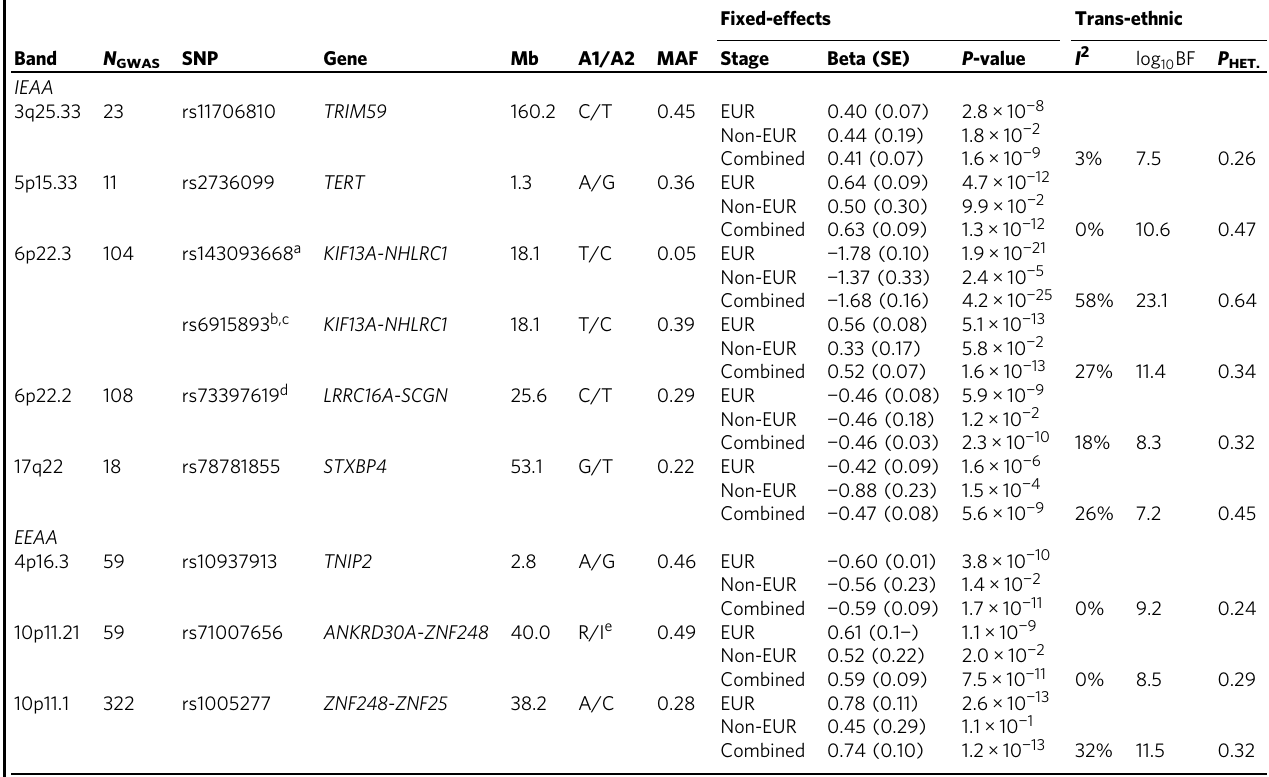
Table 1 Meta-analysis of GWAS of epigenetic age acceleration in